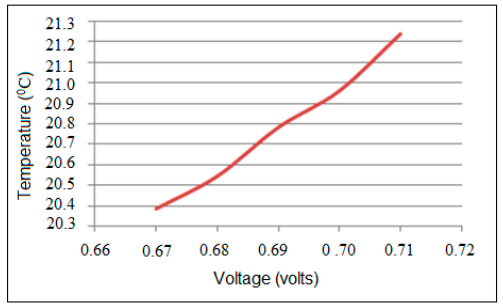
Figure 8. Temperature values against corresponding voltage values.